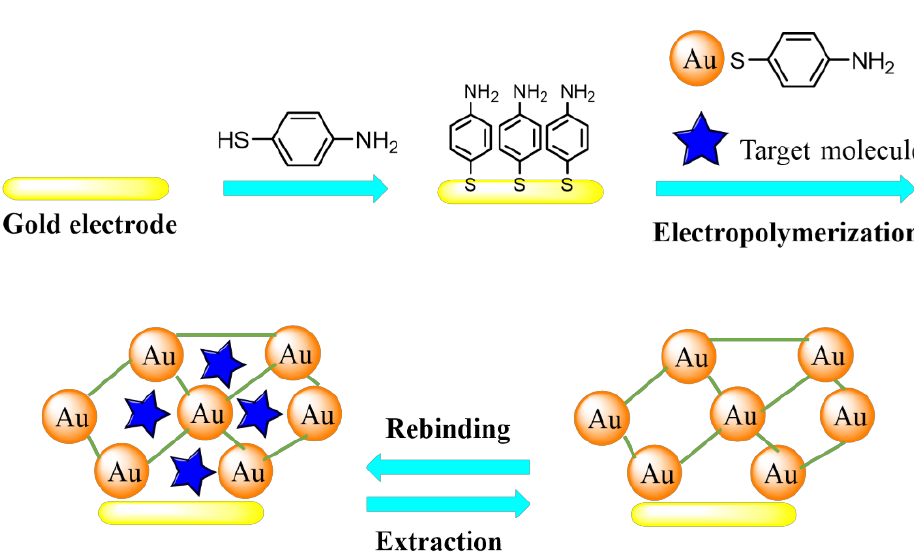
Figure 1. Schematic principle of the fabrication of this molecularly imprinted MOF sensor for template molecule detection.